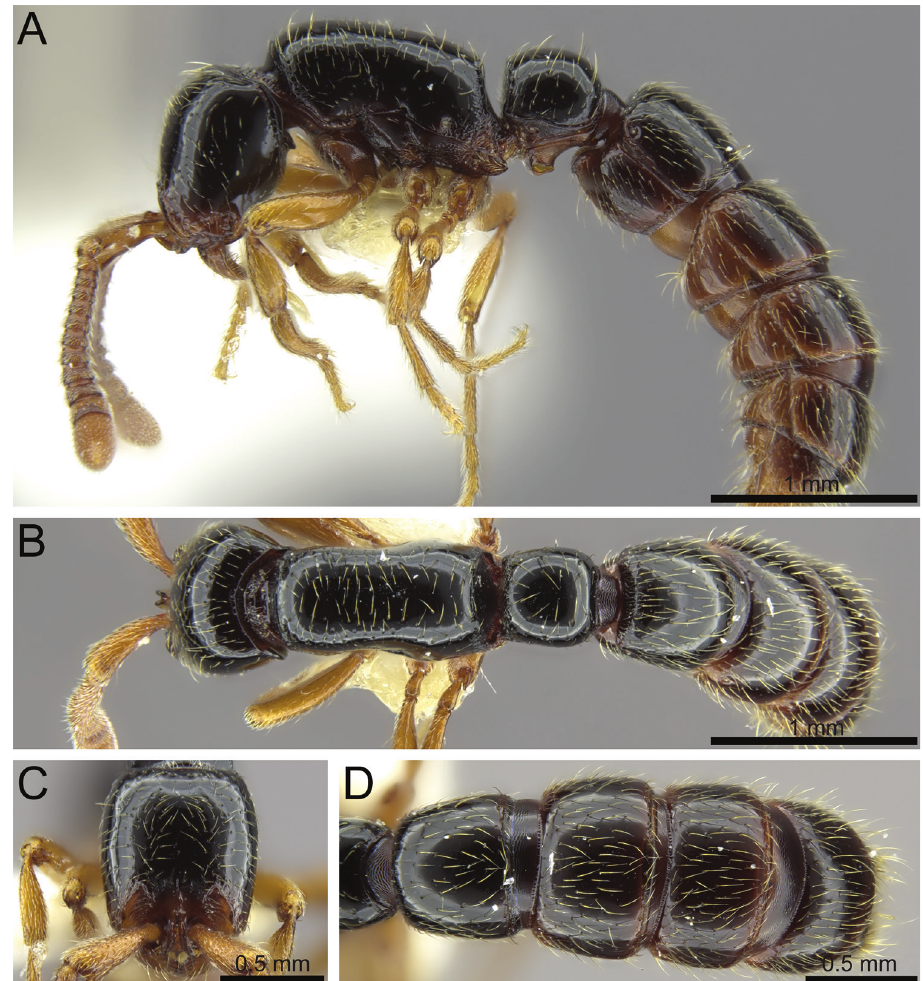
Figure 9. Zasphinctus sarowiwai sp. n. paratype worker (CASENT0764650). A Body in profile B Body in dorsal view C Head in full-face view D Abdominal segments III–VI in dorsal